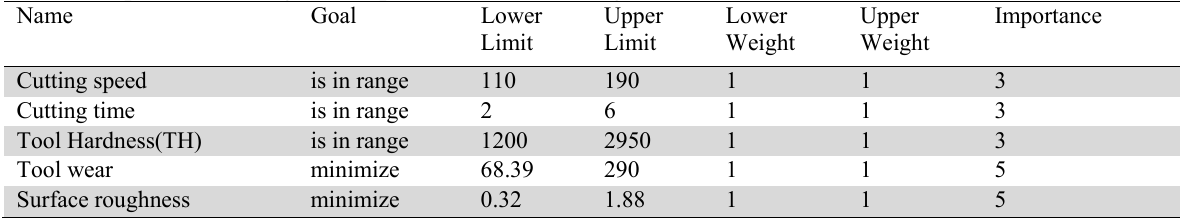
Fig.7 . Effect of cutting speed and tool hardness on surface roughness